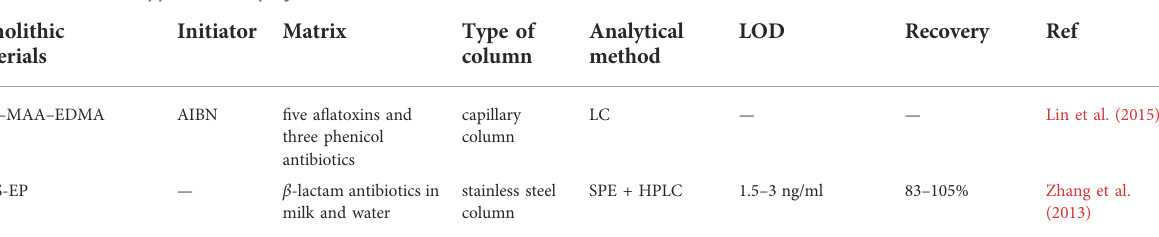
TABLE 2 ( Continued ) Application of polymer monolithic columns in